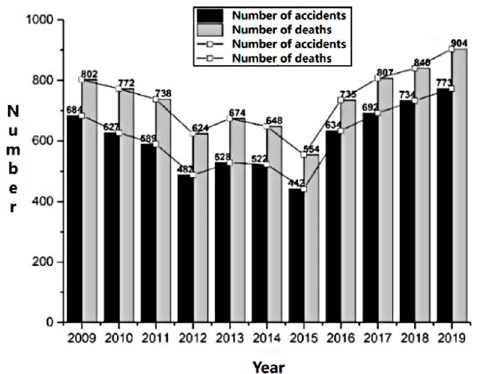
Figure 1. 2009–2019 China’s housing municipal engineering production safety accidents.